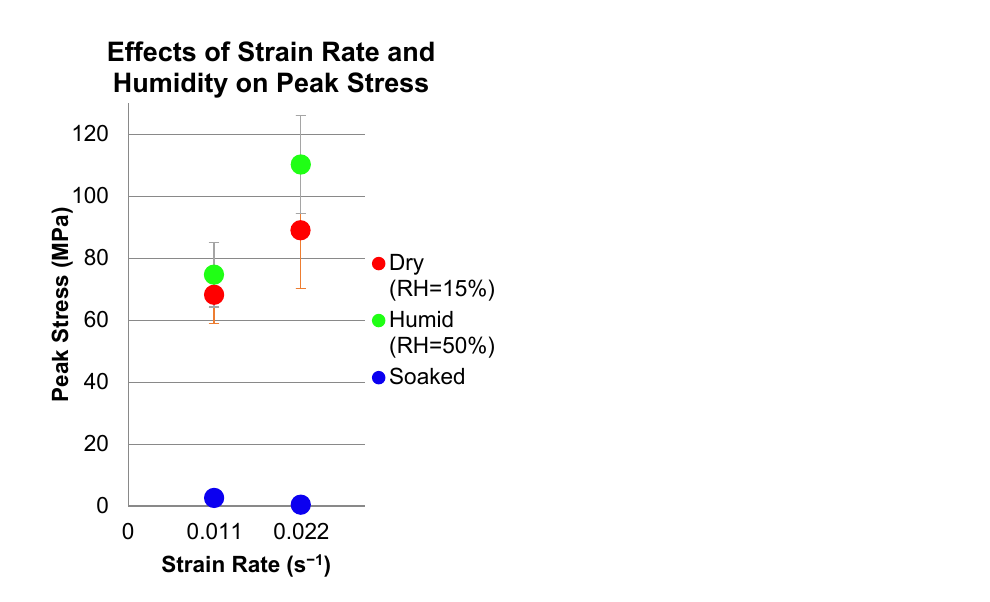
Figure 9. Summary of average peak stress versus strain rate for PVA conditions tested. Soaked samples tested at RH = 50%.